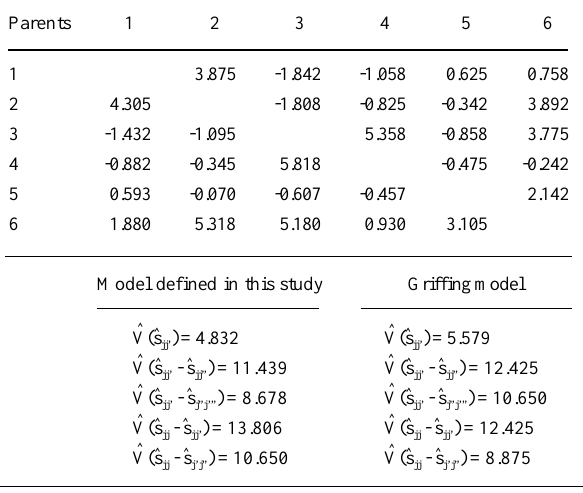
Table IV - Estimates of the SCA effects of different populations ) for the diallel analyses using the model defined in this study (s jj’ (values above the diagonal) and the Griffing (1956b) model (values below the diagonal), as well as estimates of variances of the effects and of contrasts between them.